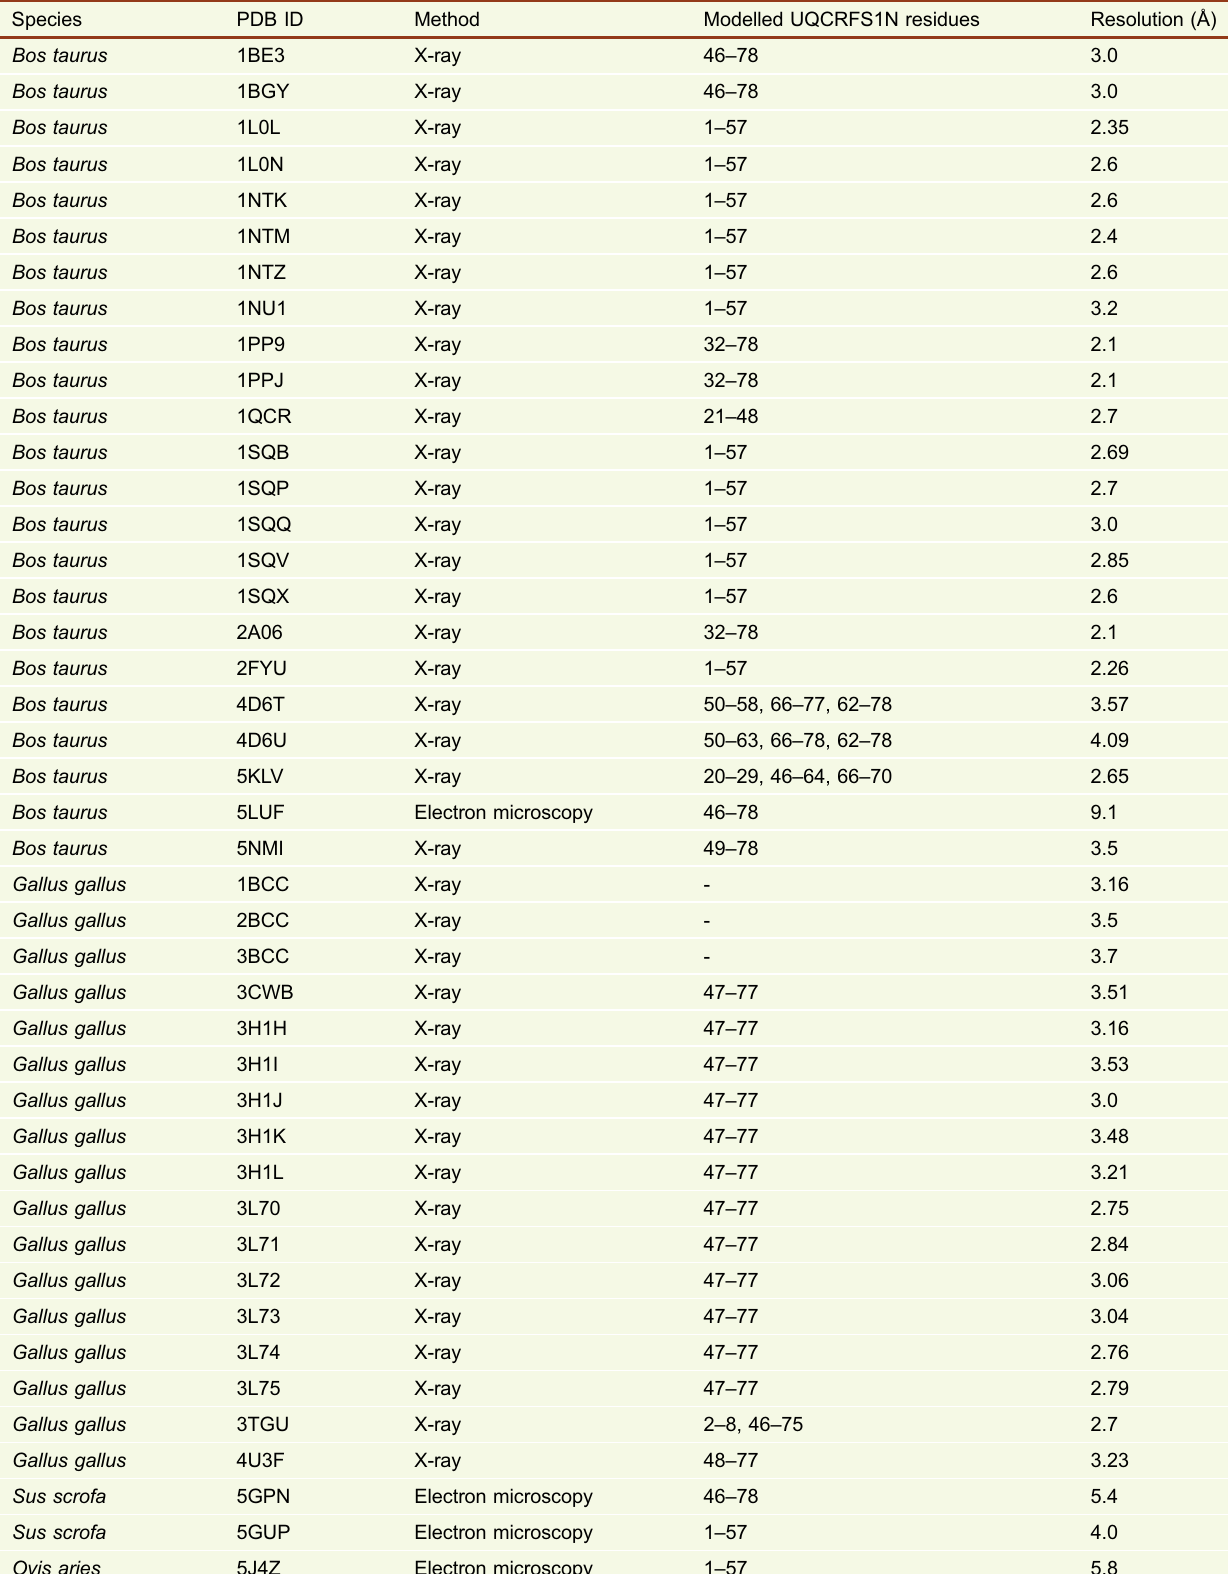
Table 1. Modelled UQCRFS1N residues in published CIII